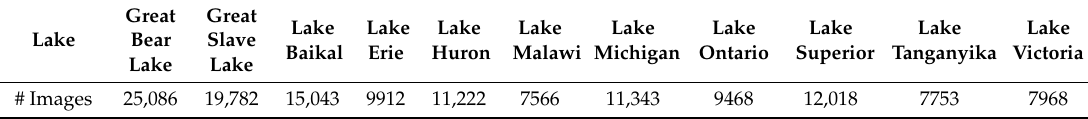
Table 1. Number of satellite images acquired per lake over the 16 year study period.